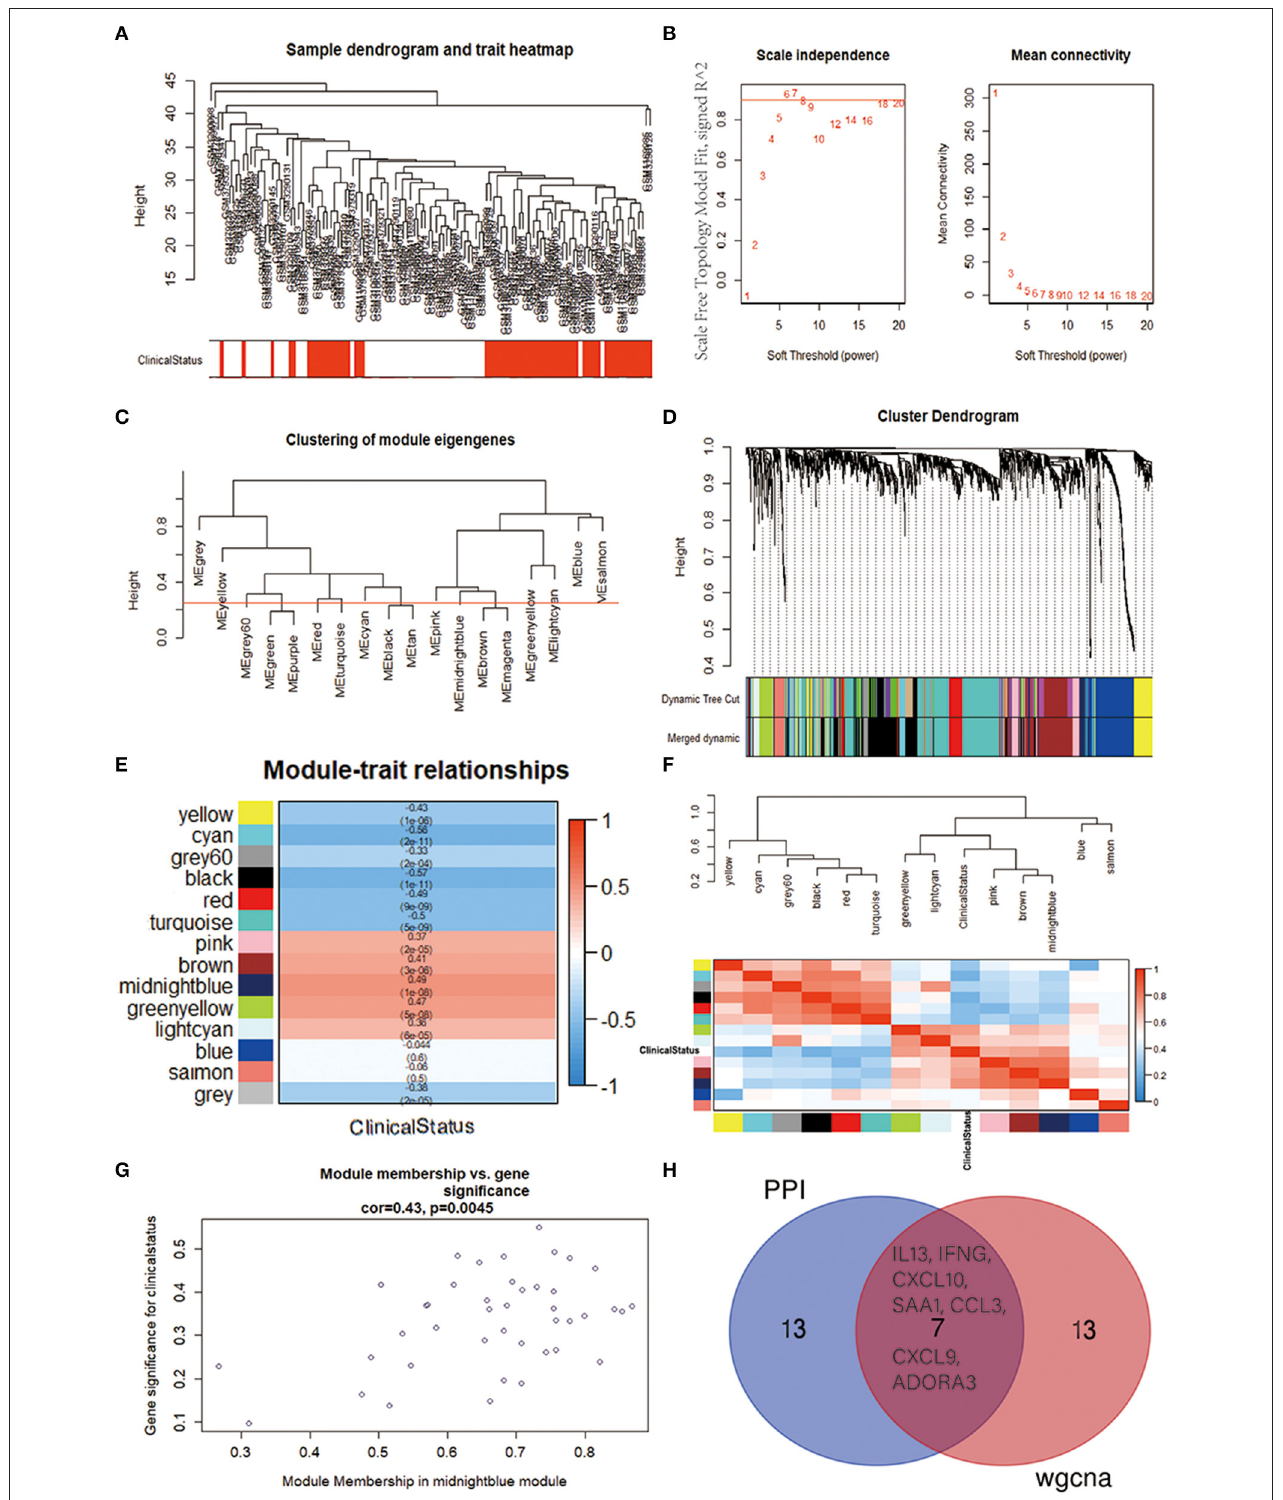
FIGURE 5 | Identification of crucial modules associated with IPAH by WGCNA. (A) Clustering dendrograms of genes from bath-normalized four datasets. In the column of clinical status, red indicates IPAH, and white means the control. (B) The scale-free fit index (left) and the mean connectivity (right) for various soft-thresholding powers. (C) Clustering of module eigengenes. The cut height (red line) was 0.25. (D) Dendrogram of the DEGs clustered based on a dissimilarity